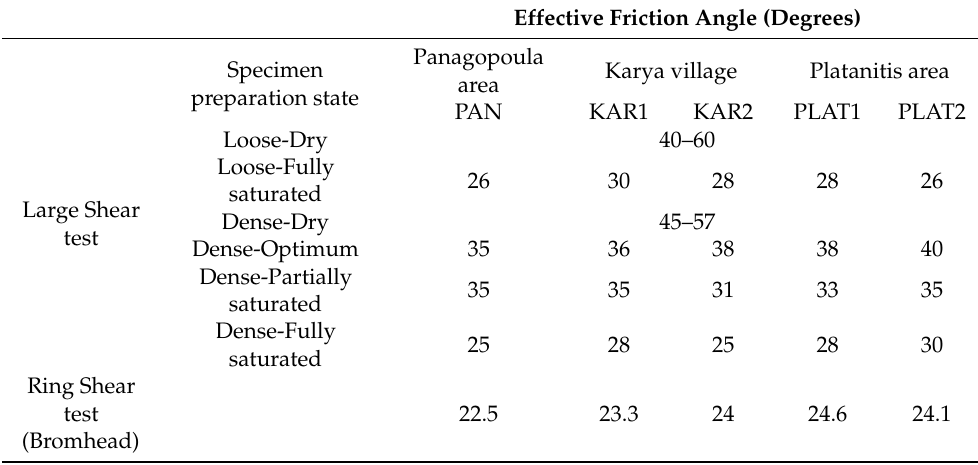
Table 5. Effective angles of friction obtained by large and ring shear